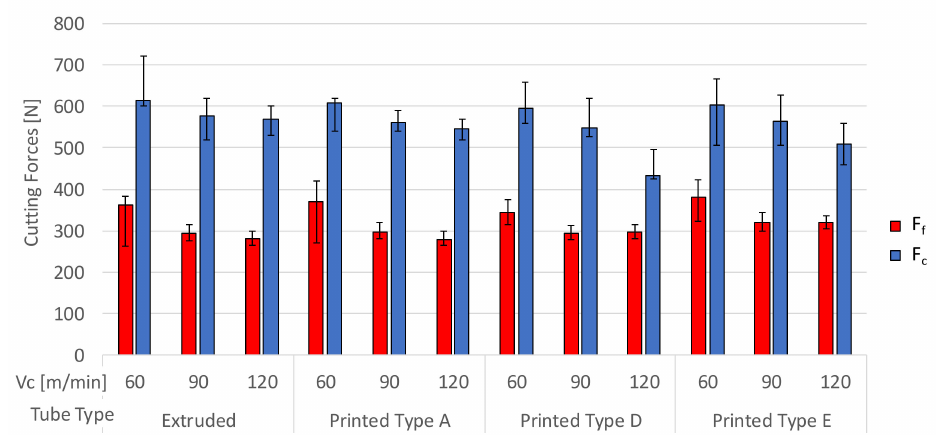
Figure 5. Average cutting forces (F c and F f ) for the extruded and AM tube samples A, D, and E with a variation in